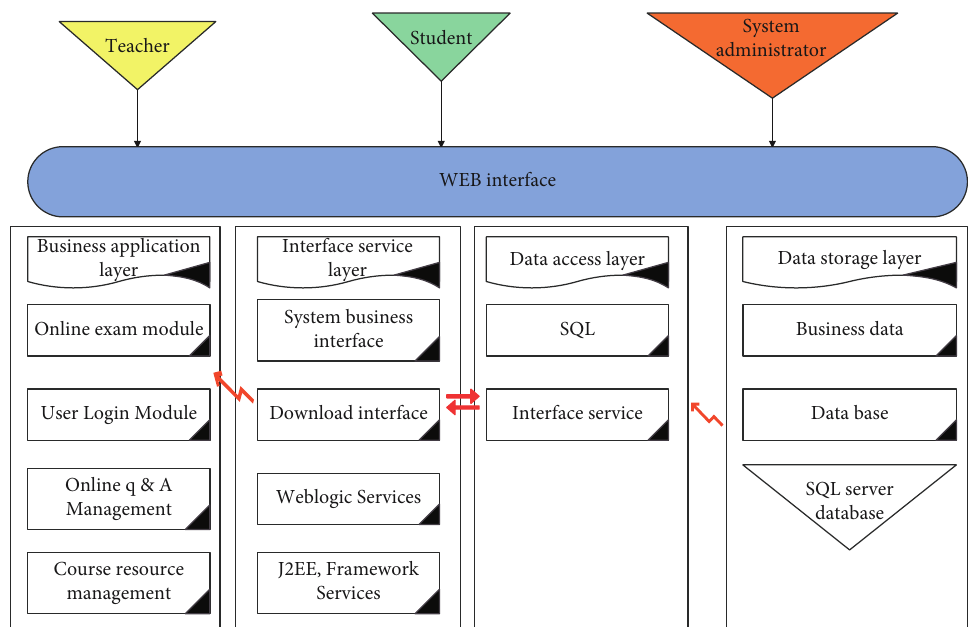
Figure 6: Multimedia popular music teaching system incorporating semifinished teaching strategies.